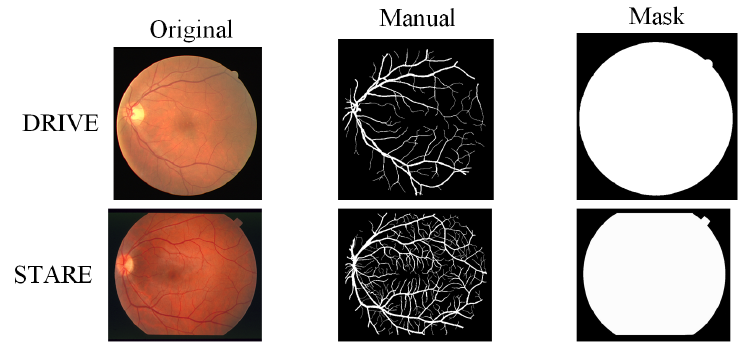
Figure 2. Data example: the images from left to right are the original image, the manually segmented label, and the mask